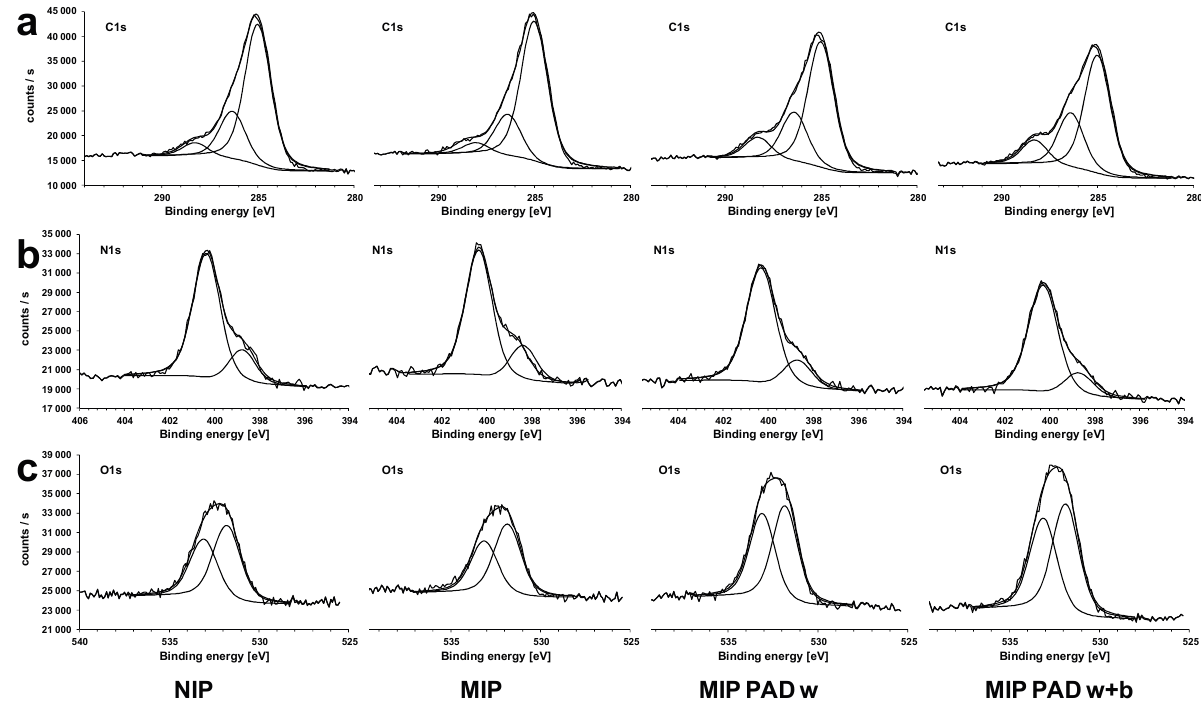
Figure 6. XPS spectra of NIP and MIP after polymerization, MIP after PAD washing, and MIP after PAD washing and subsequent clofibric acid binding of ( a ) C1s, ( b ) N1s, and ( c ) O1s.